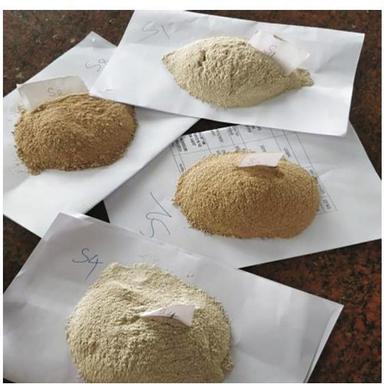
Samples of Binder Less than 63 mm.